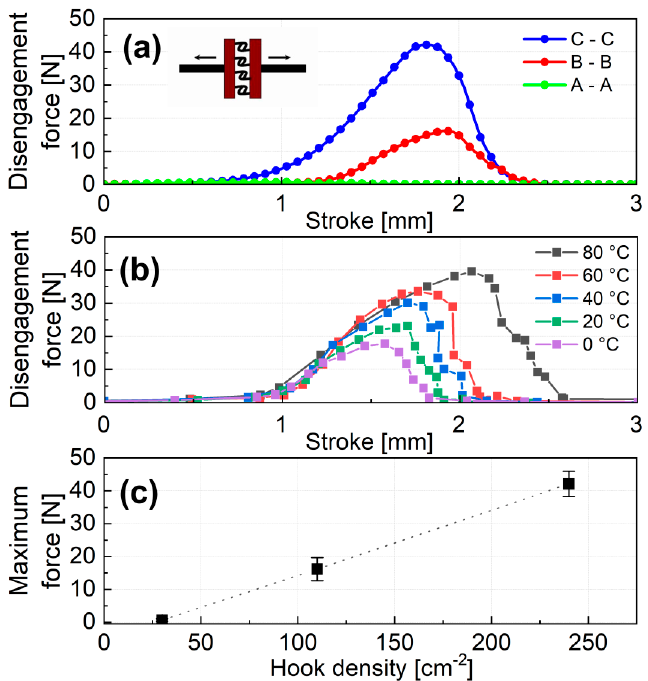
Figure 3. Detachment force versus displacement for specimens A-A, B-B, C-C at room temperature ( a ) and at various constant temperatures for specimen B-B ( b ), and the maximum disengagement force (i.e., strength) versus hook density for specimens A-A, B-B, C-C at room temperature ( c ).